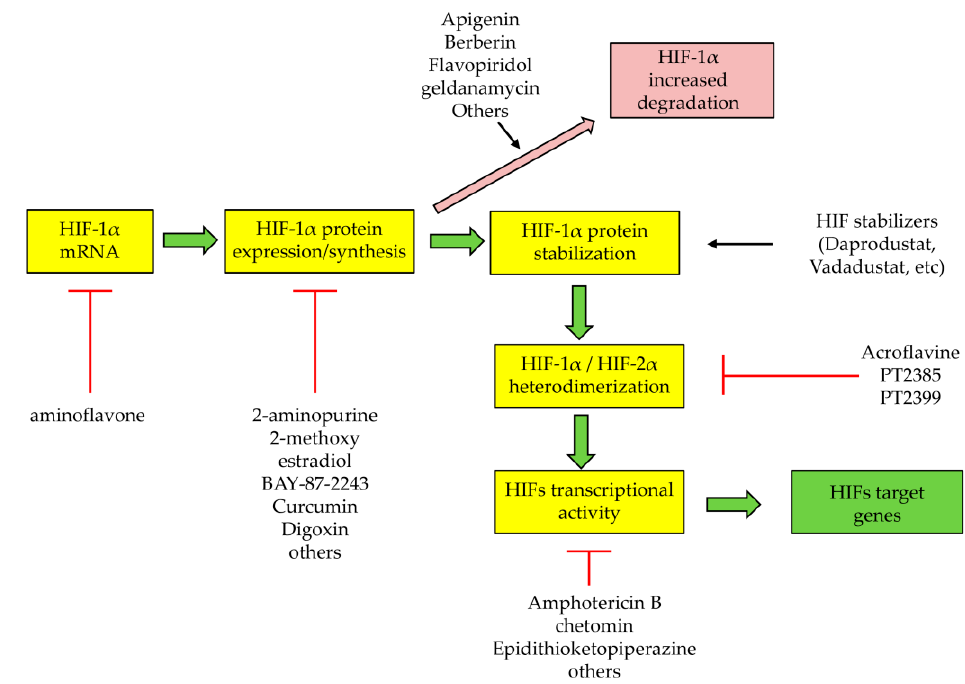
Figure 3. Site of action of drugs, small molecules and other agents acting either as HIF α subunit inhibitors or stabilizers. The site of action is shown in the ideal sequence of events, ranging from the HIF α subunit mRNA to the transcriptional activity of heterodimeric HIFs. Please note that the indicated drugs/small molecules/agents just represent a small selection of those developed in these years. For a more comprehensive list and detailed analysis, please refer to Reference [142].